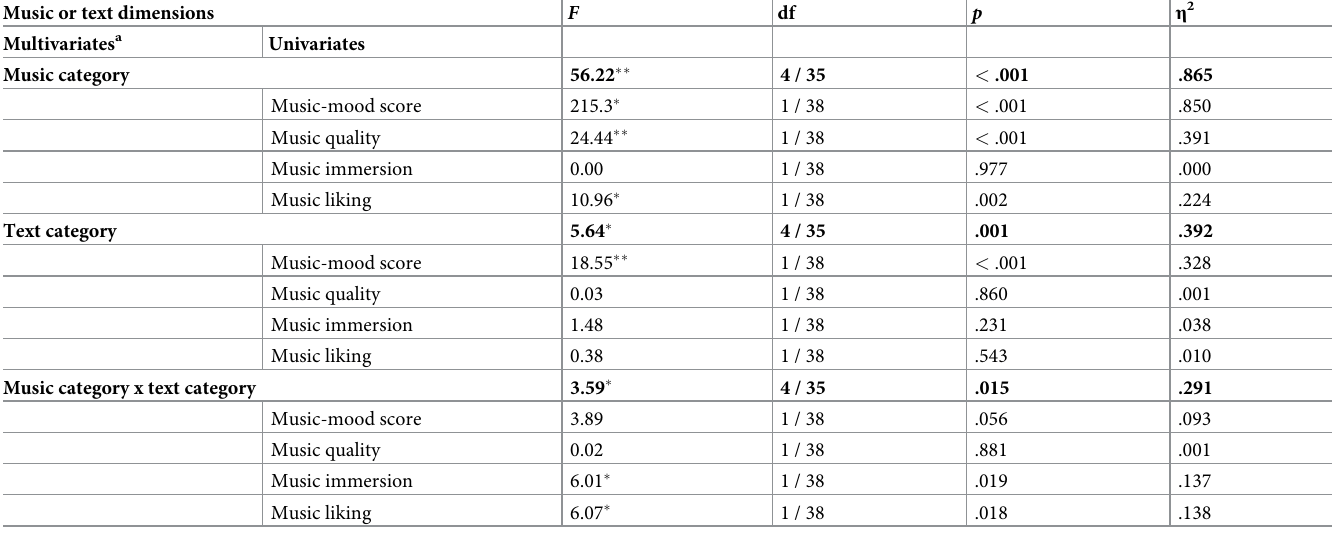
Table 2. Results of a 2 (music category) x 2 (text category) rmMANOVA on perceived mood score, quality, immersion, and liking of the music. Multivariate and uni- variate main effects and